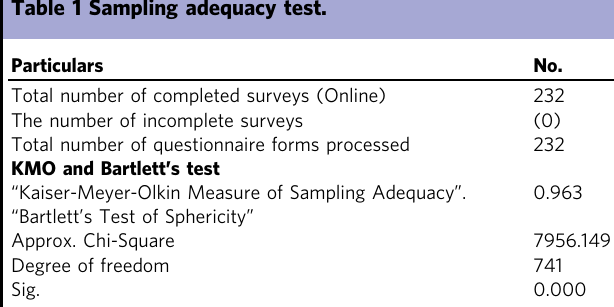
Table 1 Sampling adequacy